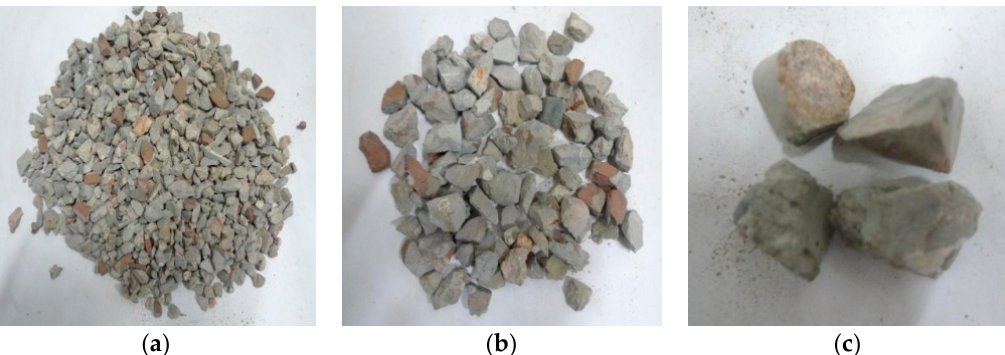
Figure 9. Concrete particles after slow heating up to 600 °C and sieving (impact speed 14.2 m/s), water cooling. ( a ) 5 mm (62.18%); ( b ) 10 mm (23.14%); ( c ) 16 mm (14.62%).